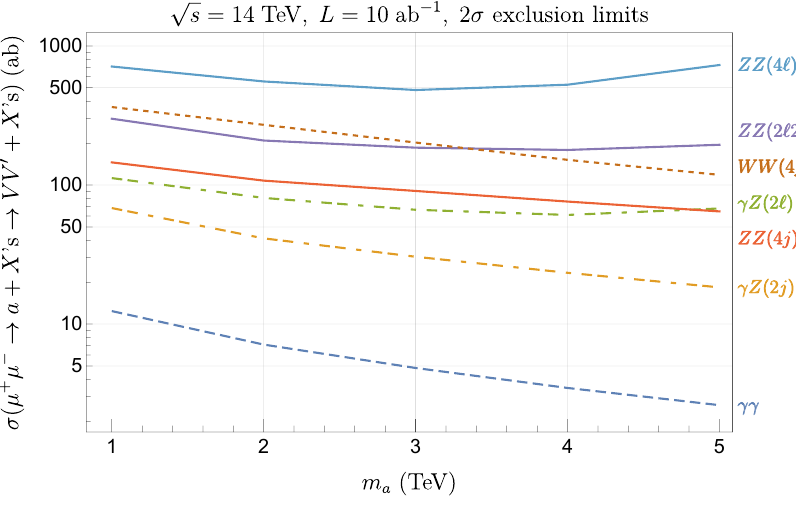
Figure 6 . Projected 2 σ exclusion limits on the VBF production cross section times the branching fraction of the ALP to a specific diboson final state, at a 14-TeV muon collider with L = 10 ab − 1 . Solid lines are exclusion limits from the analyses of a → ZZ with different secondary decays of Z ’s, short dashed line is the exclusion limit from the analysis of a → WW with W ’s decaying hadronically, long dashed line is the exclusion limit from the γγ channel, and exclusion limits from a → γZ analyses are given by the dot-dashed lines. The W and Z decay products are indicated in the